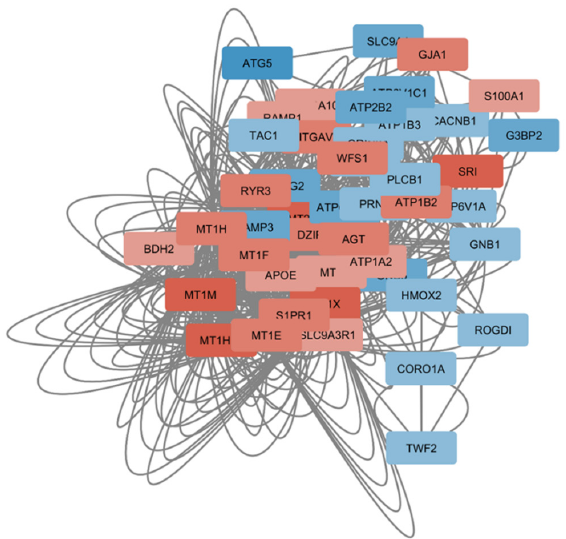
Figure 3. Network constructed using the significantly modulated genes in SCZ and belonging to the “Cellular ion homeostasis” biological process. Nodes are color-coded based on the z-value obtained from the meta-analysis of the GSE53987, GSE12649 and GSE21138 datasets.